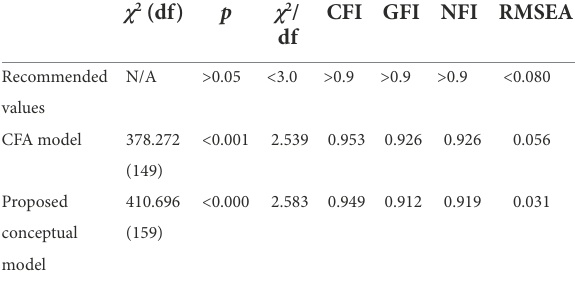
TABLE 2 Goodness-of-fit indices and model fits.